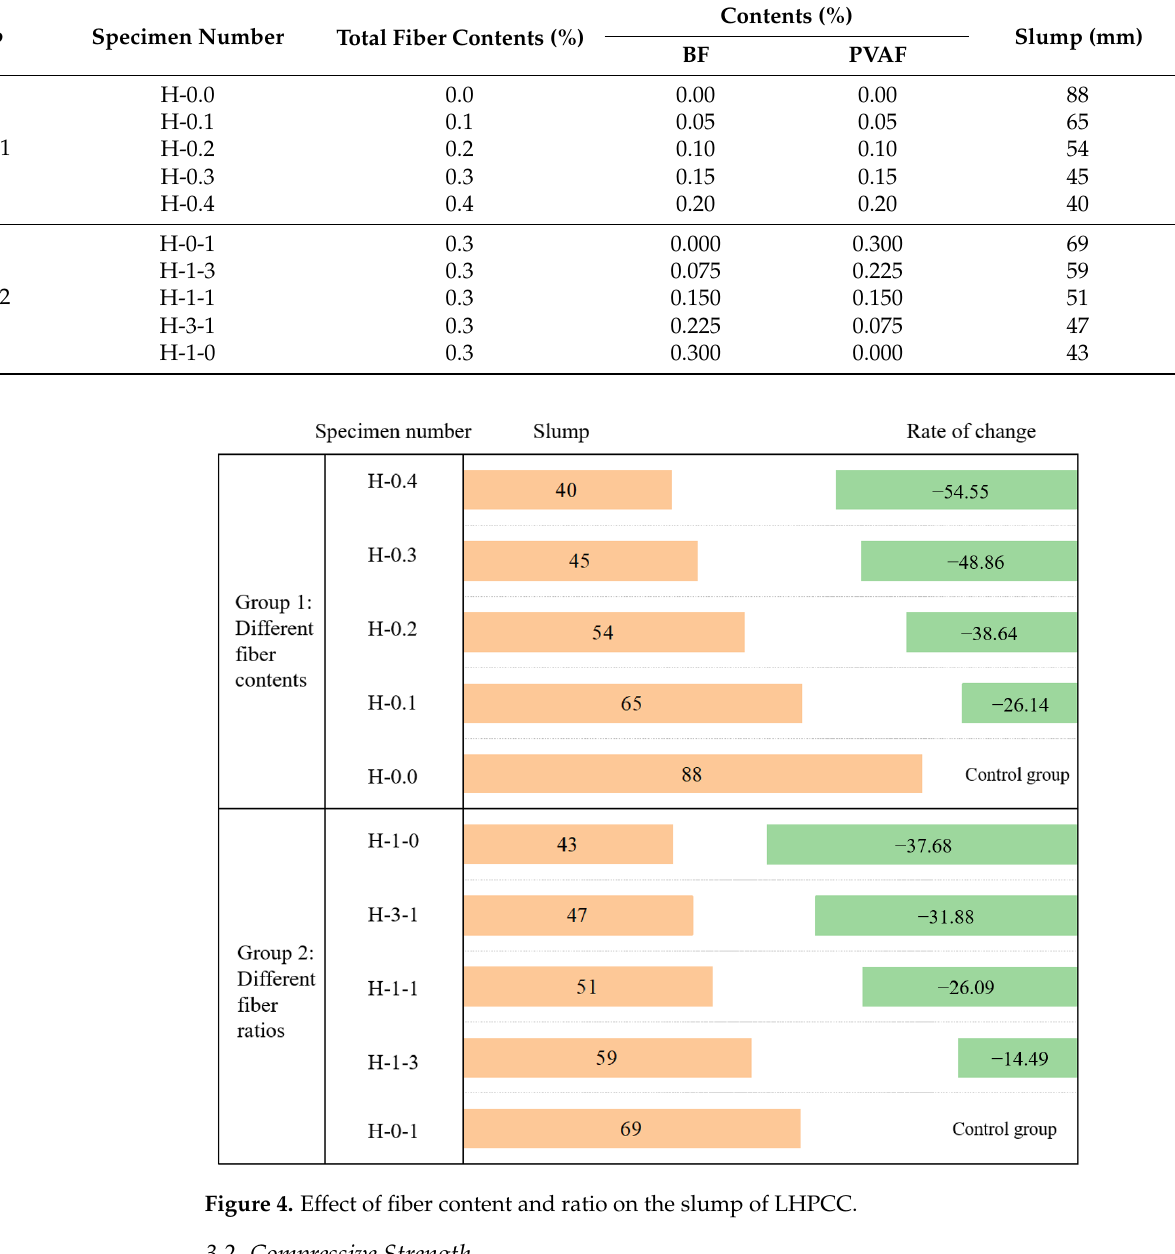
Table 8. Liquidity test results of fiber ‐ reinforced LHPCC.